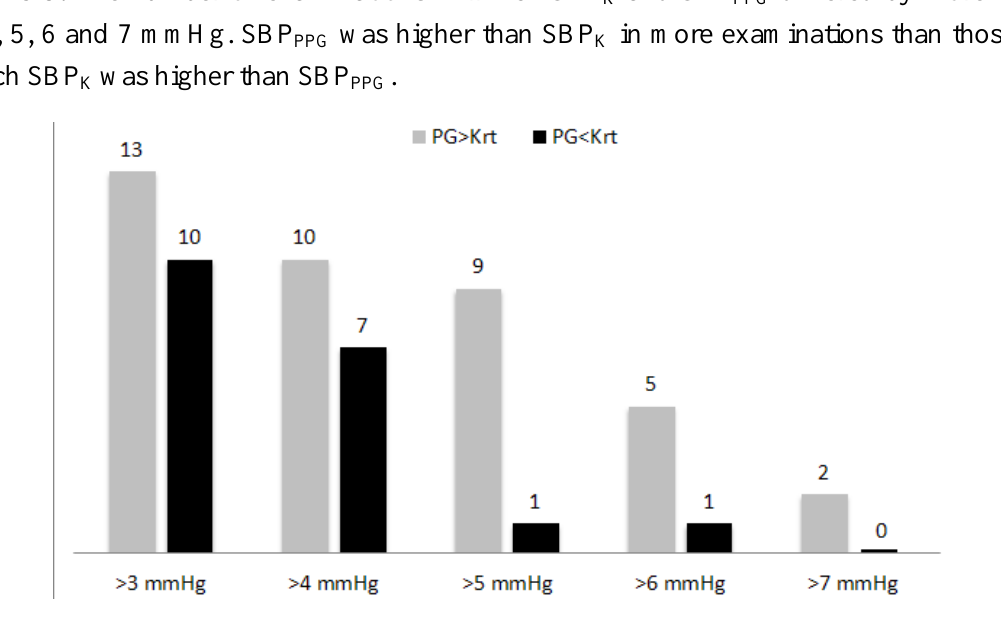
was higher than SBP PPG PPG